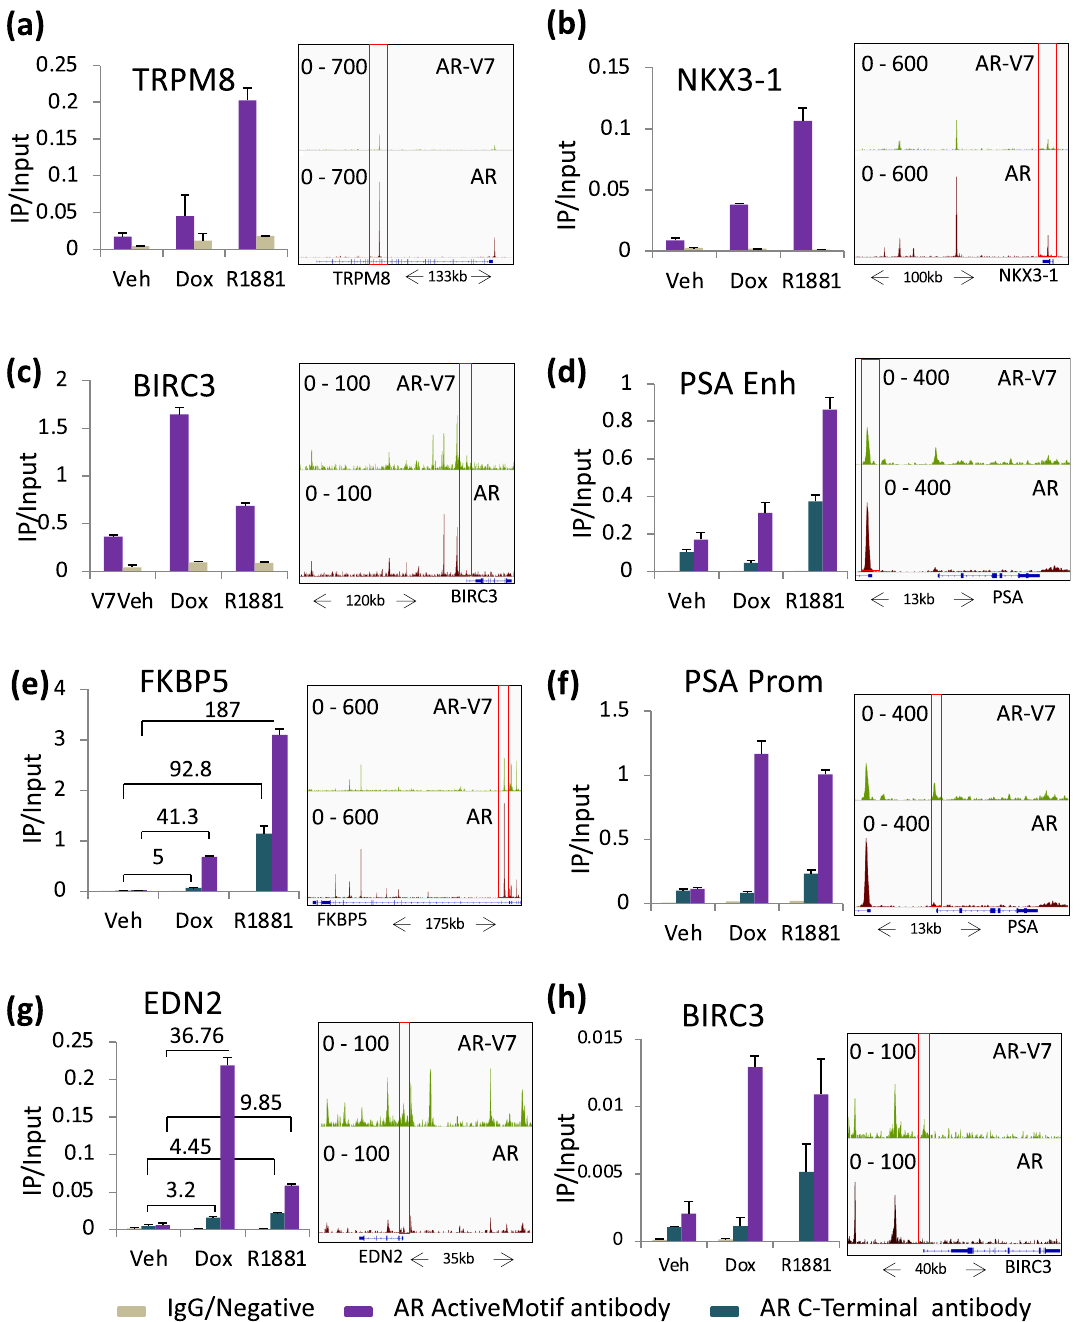
Figure 4. AR-V7 recruits only a small amount of AR to chromatin binding sites. ( a – c ) ChIP-qPCR confirmation of AR and AR-V7 binding at ( a ). gene induced by AR (TRPM8), ( b ) gene induced by both isoforms (NKX3-1) and c . gene induced by AR-V7 (BIRC3). ( d–h ) A comparison of recruitment measured by ChIP-qPCR following an immunoprecipitation by the Active Motif antibody that recognizes both AR isoforms or the C-19 antibody, which recognizes only AR. ( d ) ChIP-qPCR quantification of AR and AR-V7 binding at the PSA enhancer site. ( e ) ChIP-qPCR quantification of AR and AR-V7 binding at the FKBP5 promoter site. ( f ) ChIP-qPCR quantification of AR and AR-V7 binding at the PSA promoter site. ( g ) ChIP-qPCR quantification of AR and AR-V7 binding at the EDN2 promoter site. ( h ) ChIP-qPCR quantification of AR and AR-V7 binding at the BIRC3 promoter site. ChIP-exo data using Active Motif antibody in 20 ng/mL Dox treated LNCaP AR-V7 cells and 10 nM R1881 treated LNCaP cells. Genome browser tracks visualizing ChIP-exo signal at the corresponding gene are plotted on the right with the site analyzed by ChIP qPCR enclosed in a red box. All qPCR plots are the ChIP signal normalized to input and data are plotted as a mean of two biological replicates from the same experiment; error bars are SEM. Each experiment was performed a minimum of three times and a representative experiment is